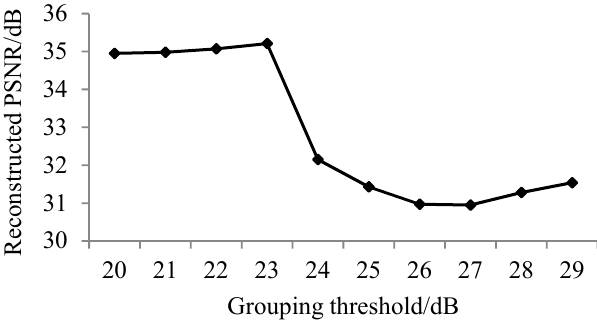
Figure 4. Average reconstructed PSNR of key bands for different groups.